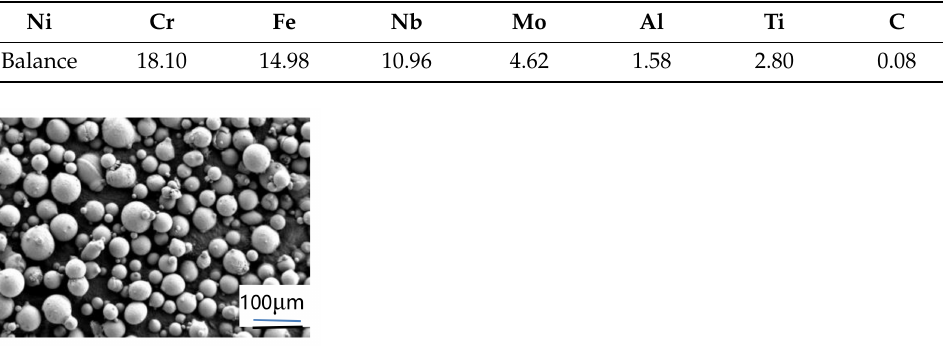
Table 1. Chemical compositions of raw Inconel 718 powders (wt%).